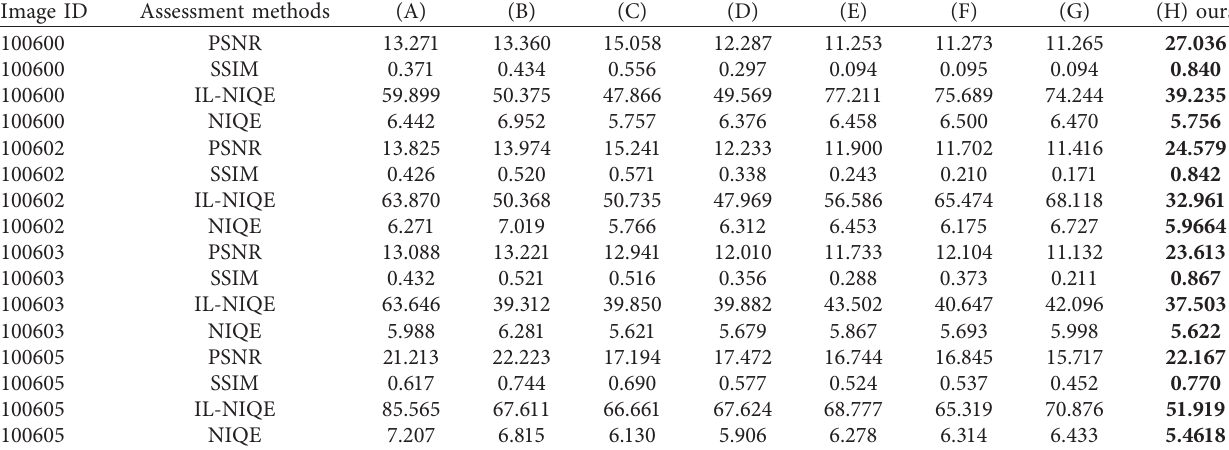
Table 3: The test results of objective IQA methods between our algorithm and S+D +underwater enhancement and restoration